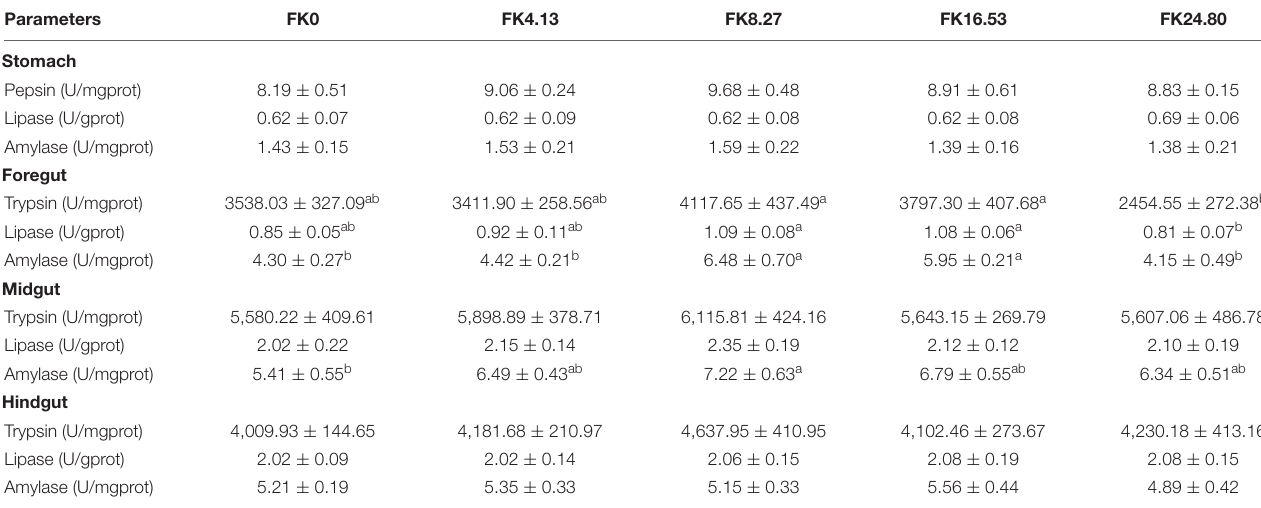
TABLE 4 | Whole-body and muscle proximate composition of black sea bream fed with different diets 1 .